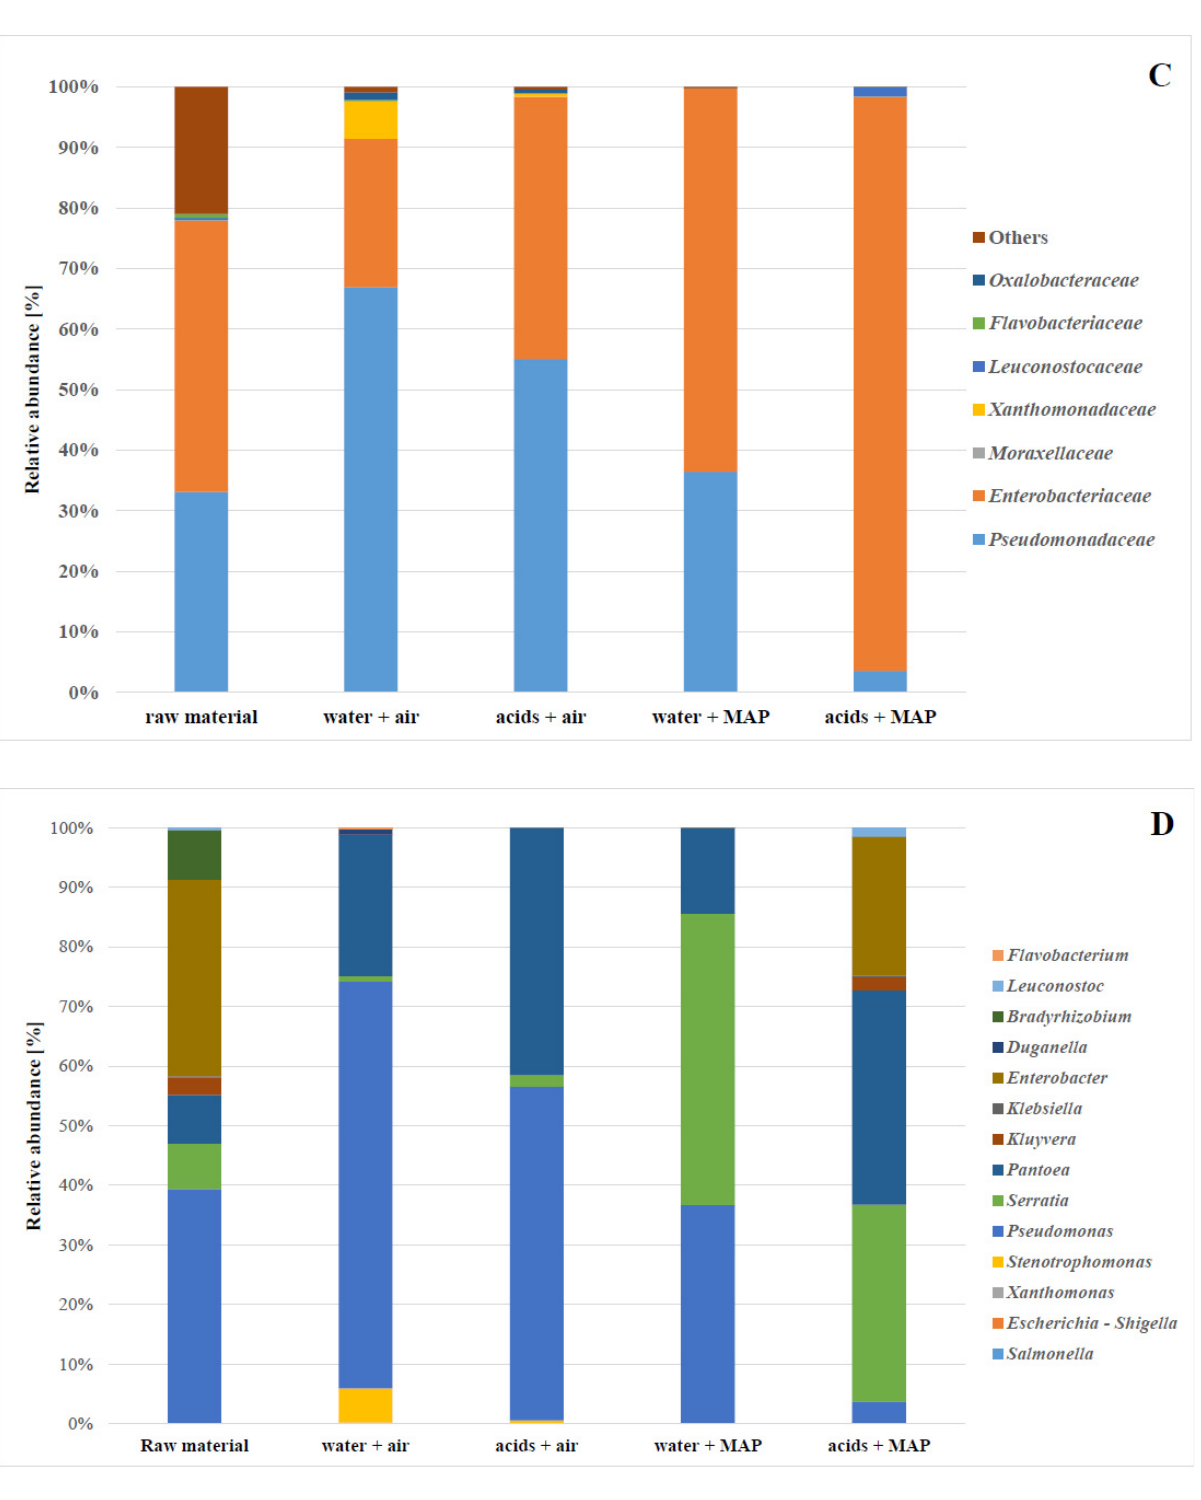
Figure 3. Relative ratio of phyla ( A ), selected classes ( B ), families ( C ), and genera ( D ) of bacteria in raw carrots and minimally processed carrots stored in refrigerated conditions for 17 days.